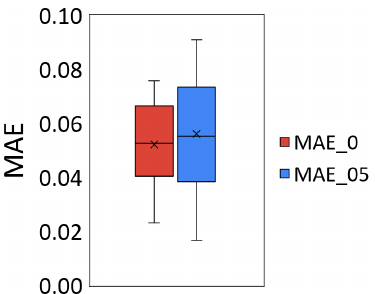
Figure 8 . MAE of the GDD_0 and GDD_05 models (MAE_0 and MAE_05 respectively) in the period 6 th April - 30 th